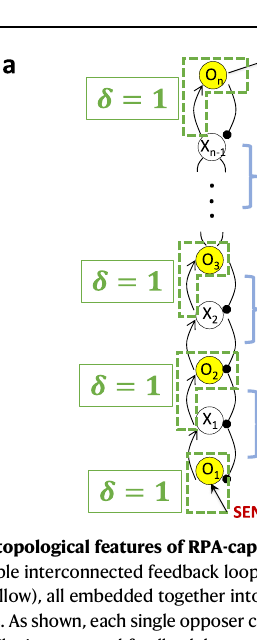
system rowspan are passed from the ‘ distal ’ opposer invariant to the ‘ proximal ’ opposer invariant. Opposer nodes indicated in yellow. b In CRN subnetworks of balancer type, polynomial rowspan invariants are passed from the diverter node, along parallel pathways, to the connector invariant. Balancer nodes indicated in blue, connector node indicated in green.